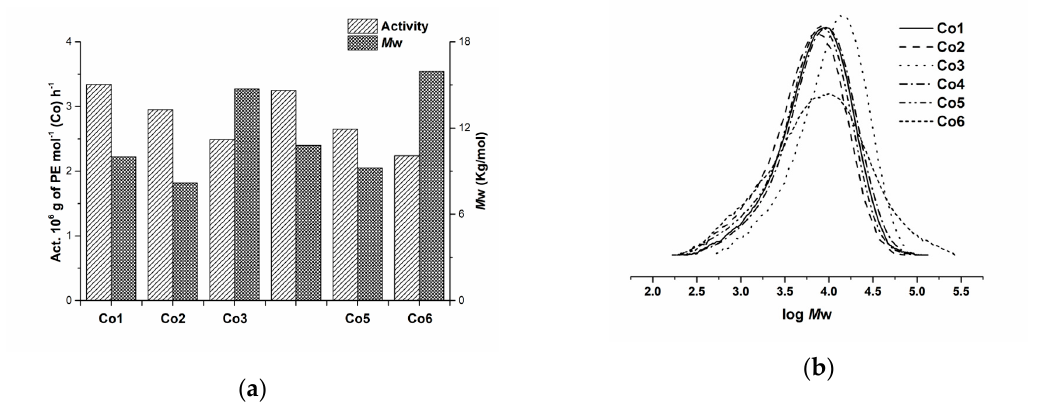
Figure 4. ( a ) Polymerization activity and M w of PE by Co1 ‐ Co6/ MMAO; ( b ) GPC curves of PE obtained by Co1 – Co6/ MMAO (runs 3 and 12–16, Table 3).